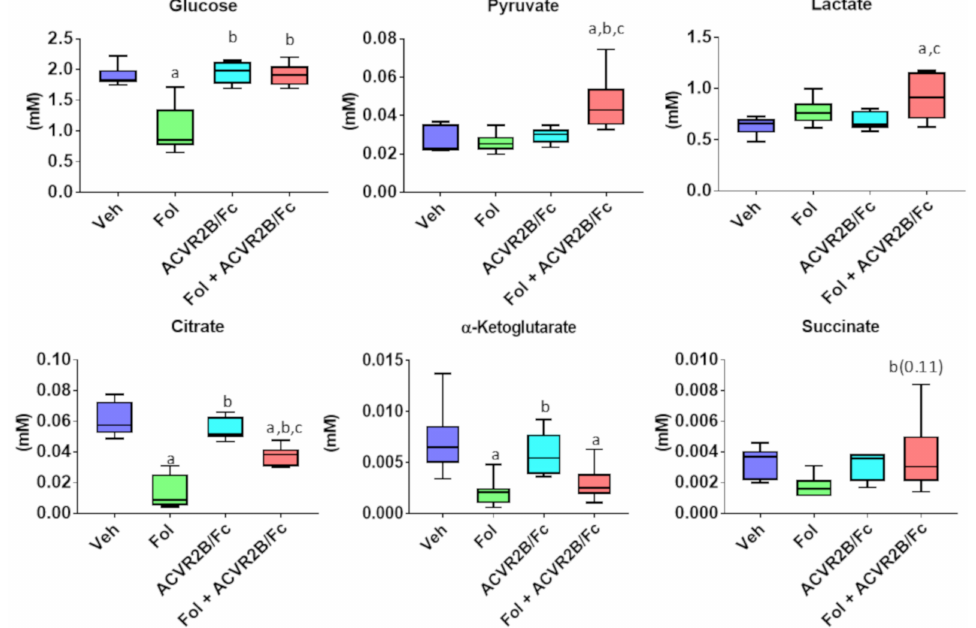
Figure 3. Serum levels of selected metabolites representing central energy metabolism. Boxplots are shown with mean value, interquartile range, and whiskers that extend to the 10th and 90th percentiles. Significance di ff erences include p -values < 0.05 for a vs. Veh, b vs. Folfiri, c vs. ACVR2B /